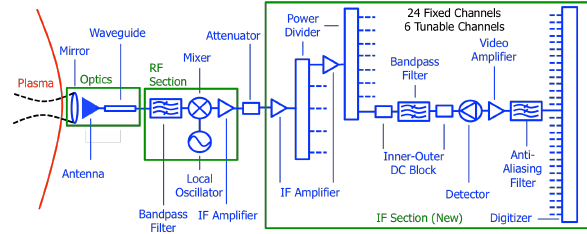
Figure 1. Reproduced from [8]. Block diagram showing the layout of the new AUG CECE diagnostic.